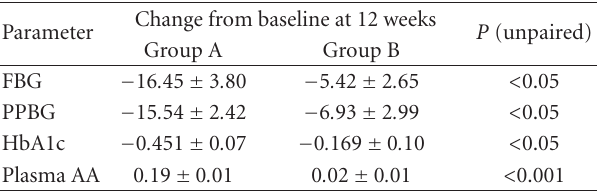
Table 4: Comparison of e ff ects of metformin with vitamin C and in combination with placebo on FBG, PPBG, HbA1c, and plasma AA at 12 weeks in patients with type 2 diabetes mellitus taking into account the change from